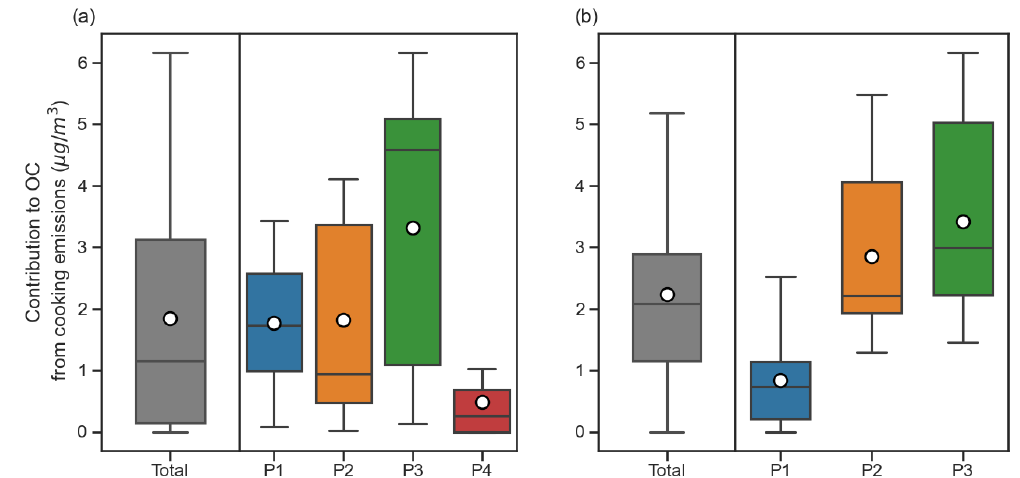
Figure 10. Cooking emissions contribution to OC ( µ g / m 3 ). ( a ) Total contribution and diurnal variation of contribution at YL site in winter. ( b ) Total contribution and diurnal variation of contribution at MK site.